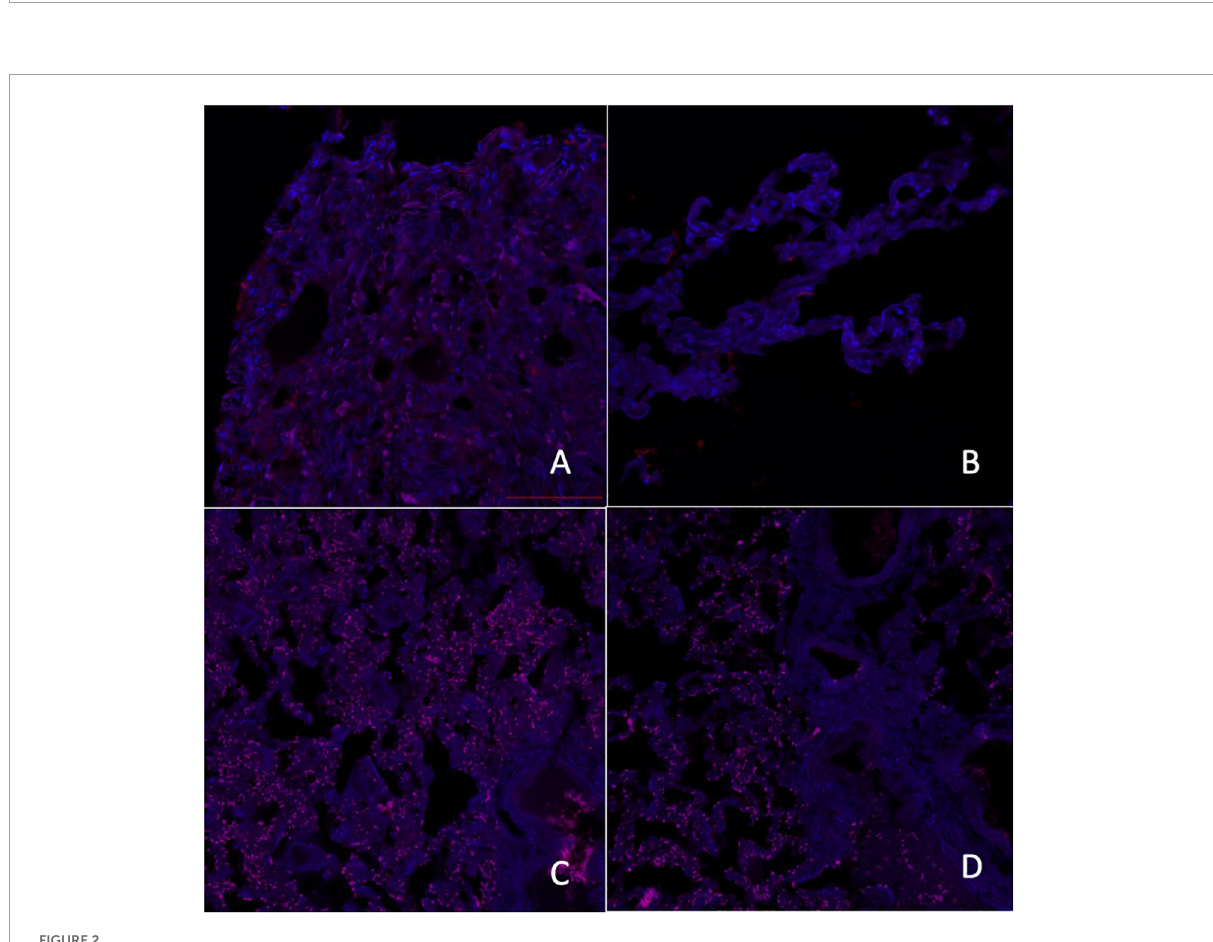
FIGURE2 Micrographs of laser scanning confocal microscopy expression of melatonin A receptors [ A –control group, C –group with ischemic cardiomyopathy (IC)] and melatonin B receptors ( B –control group, D –group with IC), red fluorescence–melatonin A and B receptors, 200 ×